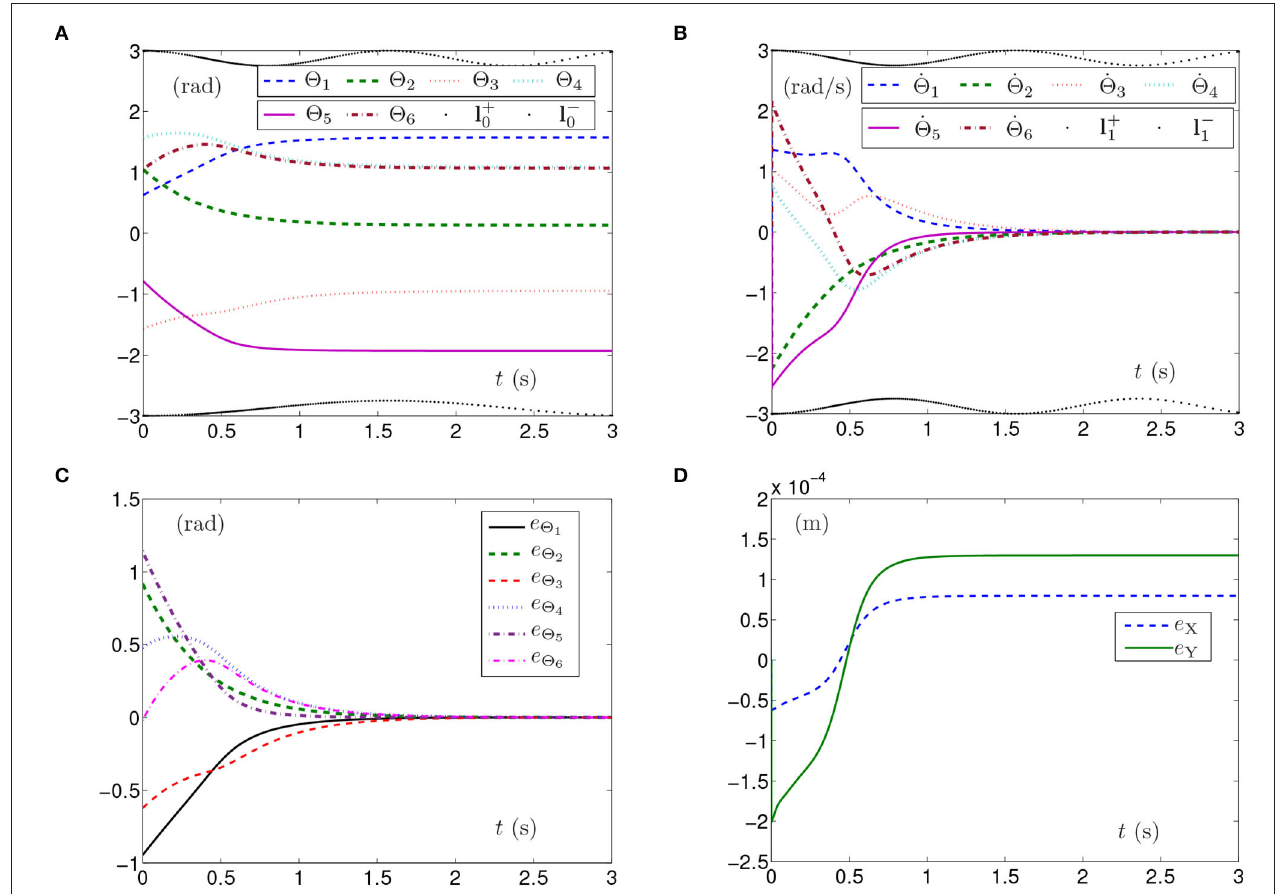
FIGURE 2 | Synthesized results of the planar manipulator using SMCS-1 with time-varying physical limits satisfied in case A. (A) Profiles of joint angles. (B) Profiles of joint-angle velocities. (C) Profiles of joint-angle errors. (D) Profiles of end-effector position